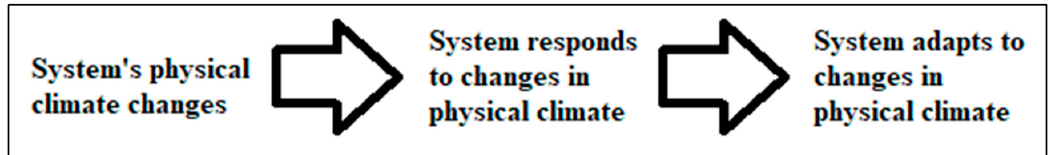
Figure 2. Flow chart describing the primary motivation for systems to adapt to climate change effects.